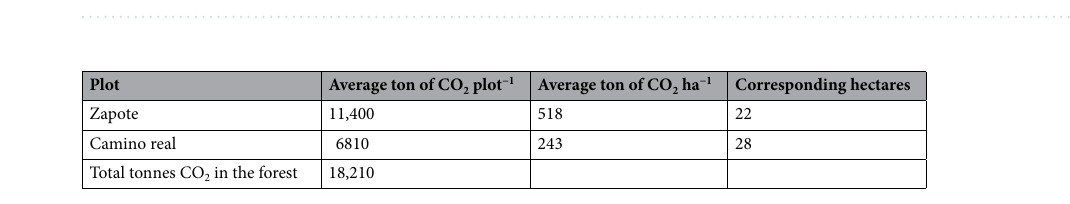
Table 1. Calculated values for the two permanent plots and the average values reported for a secondary forest and mature forest.